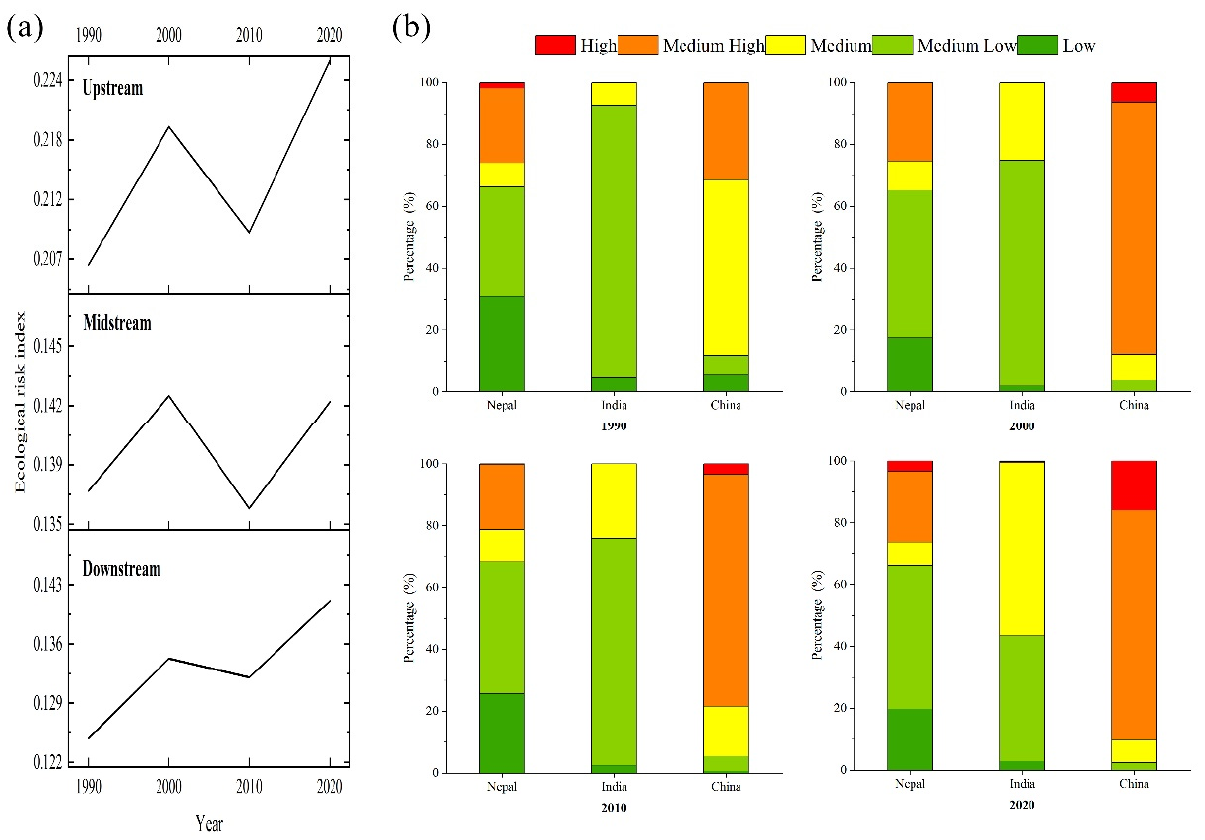
Figure 4. Ecological risk in GRB from 1990 to 2020: ( a ) sub-basin change trend, ( b ) percentage change in Nepal, India, China.